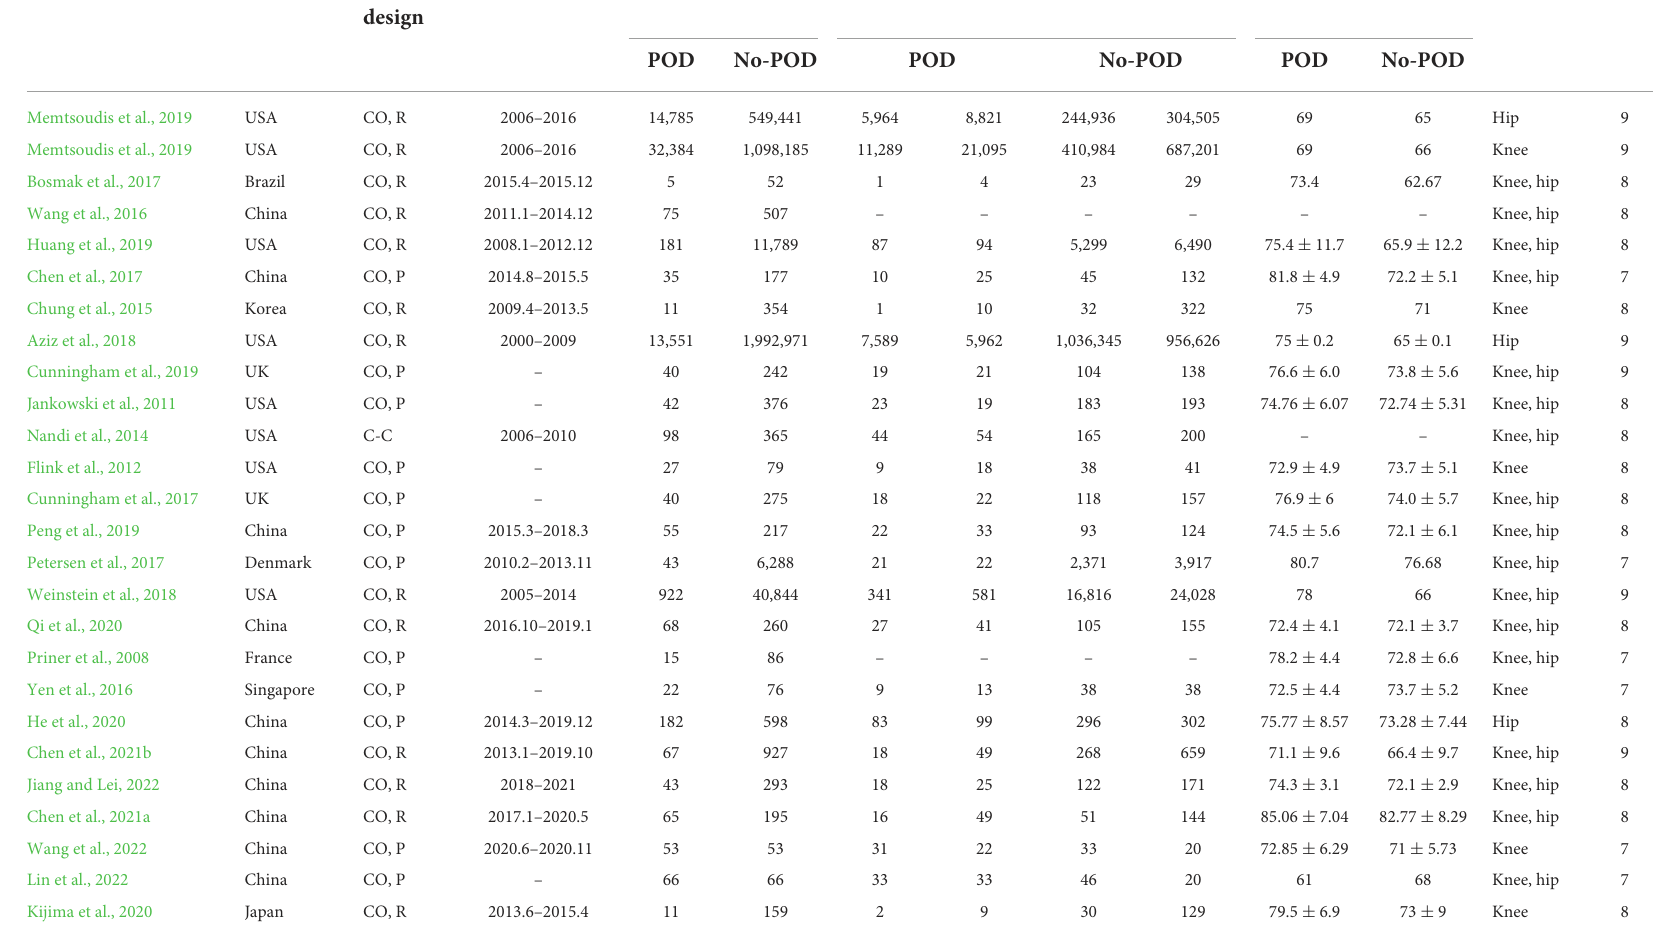
TABLE 1 Characteristics of the included